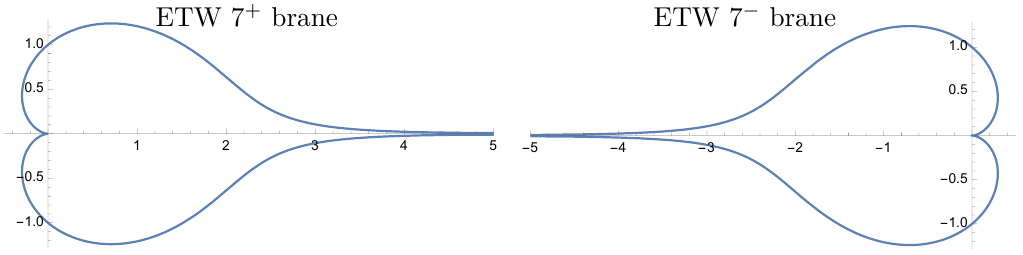
Figure 5 . Contour plot of the ϕ -dependent warp factor exp( V ( ϕ ) + 1 more intuitive depiction, we have chosen ϕ = 0 along the negative vertical